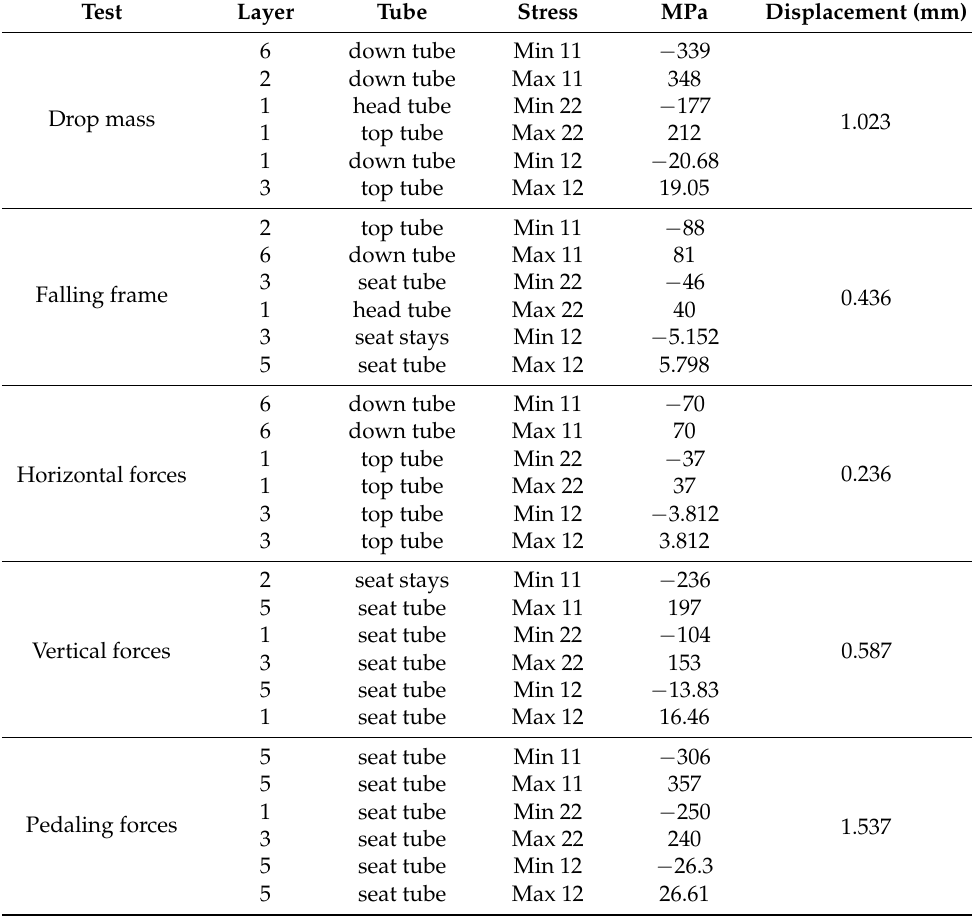
Table 25. Stress and displacement results of stacking scenario 7.